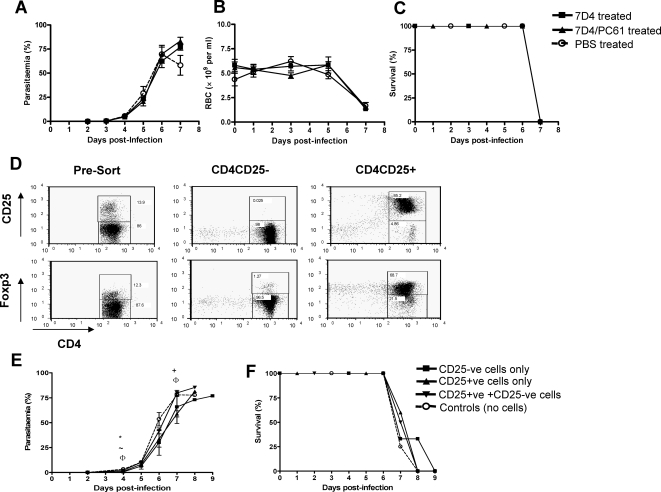
Natural Treg do not significantly contribute to the virulence of PyL infection.(A–C) Mice were given either a single dose of 0.75 mg 7D4 (IgM clone) or 0.25 mg 7D4 combined with 0.75 mg PC61 (IgG1 clone) on 3 days prior to infection with 104 PyL pRBC. The effect of anti-CD25 treatment on the course of PyL infection was examined in (A–C) C57BL/6 mice by following (A) parasitaemia, (B) anaemia and (C) weight loss. Groups consisted of 3–5 mice and data are representative of 2 independent experiments. Symbols represent significant differences (p<0.05) between groups: (A–D) # 7D4 vs 7D4/PC61; * 7D4 vs PBS; ∼ 7D4/PC61 vs PBS; (G–H) # 7D4 vs 7D4/PC61; * 7D4 vs 7D4×3; ∼ 7D4 vs PBS; + 7D4/PC61 vs 7D4×3; Φ 7D4/PC61 vs PBS; Δ 7D4×3 vs PBS. (D–F) Naive CD4+CD25− (non-Treg) and CD4+CD25hi (Treg) cells were purified by flow cytometric cell sorting and adoptively transferred alone or at a 10∶1 ratio (non Treg∶Treg) into RAG-1−/− mice prior to infection with PyL parasites. (D) shows the purity of sorted CD4+CD25− and CD4+CD25hi populations prior to adoptive transfer and the relative expression of Foxp3 within the purified populations. The affect of adoptive transfer on the course of infection was determined by monitoring (E) parasitaemia and (F) survival for the duration of the experiment. Groups consisted of 5 mice and the results are representative of 2 independent experiments. Symbols represent significant differences (p<0.05) between groups: # CD25− vs CD25+; * CD25− vs CD25−/ CD25+; ∼ CD25− vs control; + CD25+ vs CD25−/ CD25+; Φ CD25+ vs control; Δ CD25−/ CD25+ vs control.